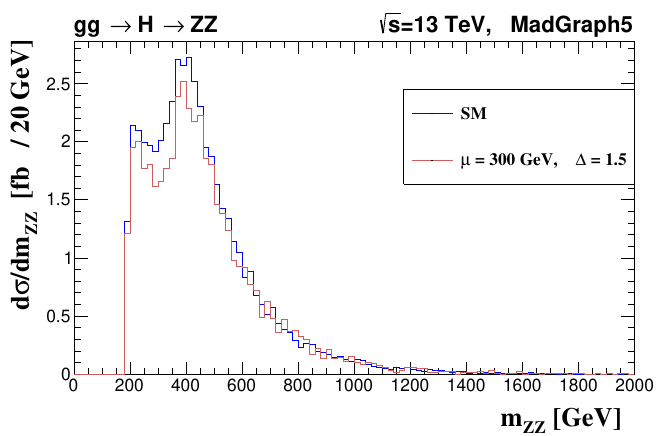
Figure 8. The gg ! ZZ amplitude.